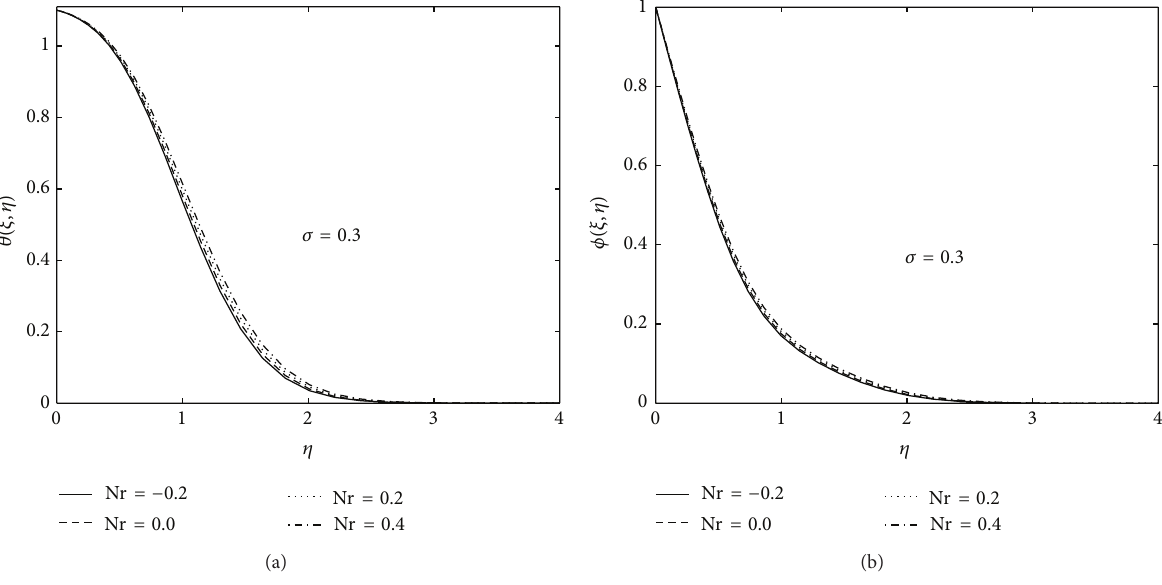
Figure 2: Effect of the buoyancy ratio Nr on 𝜃(𝜂) and 𝜙(𝜂) for 𝜉 = 0.5 , Le = 10 , Pr = 7 , Nt = 0.1 , Nb = 0.5 , and 𝐴 = 0.1 . 1 1 𝐴 = ( D 2 + c 𝑛+1/2 3 2 Le